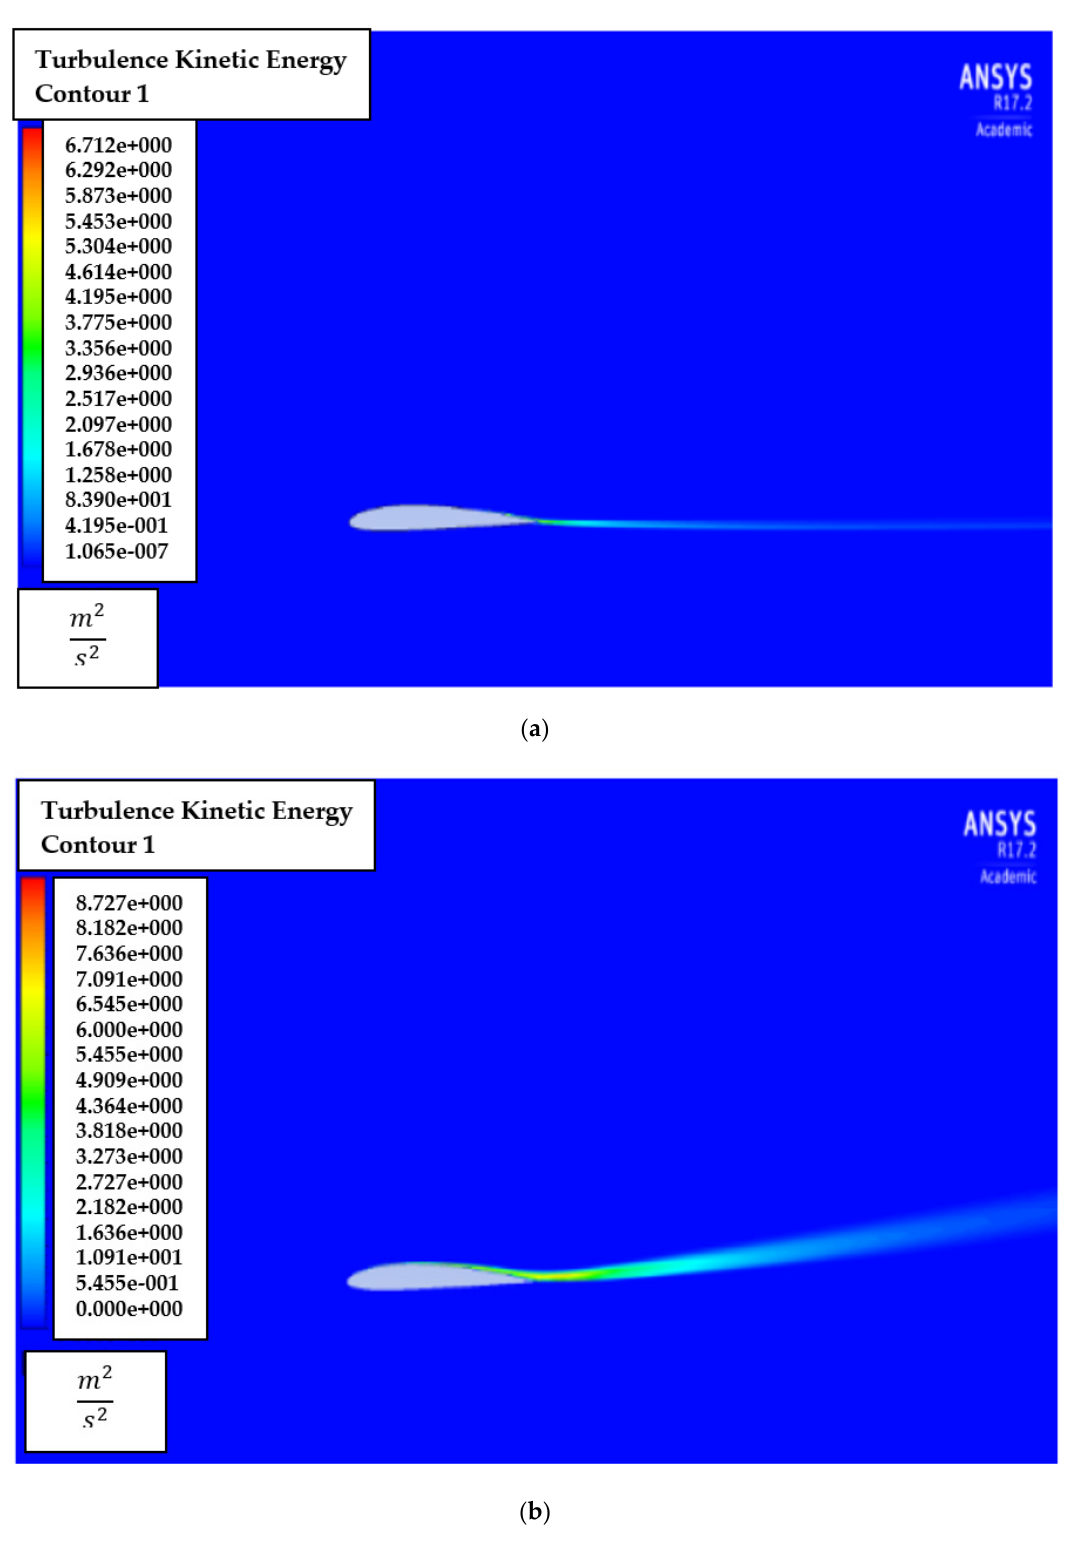
Figure 9. Turbulence intensity contour of NACA2410 with AoA ( a ) 1° and ( b ) 8°. The pressure distribution is shown in Figure 10 for AoA 1 ◦ , 5 ◦ , and 8 ◦ , respectively. As the AoA increases, it is noted that the pressure distribution at the top and bottom walls become separated from each. On average, both the C D and C L increase along with the